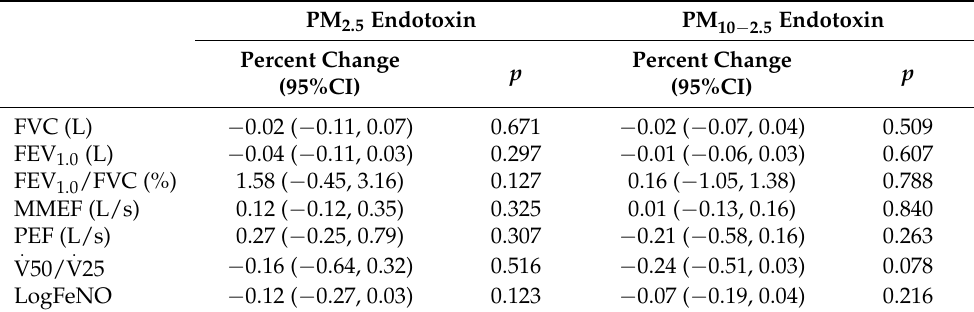
Table 5. Associations between PM 2.5 and PM 10–2.5 endotoxin concentrations, changes in pulmonary function parameters, and FeNO concentration